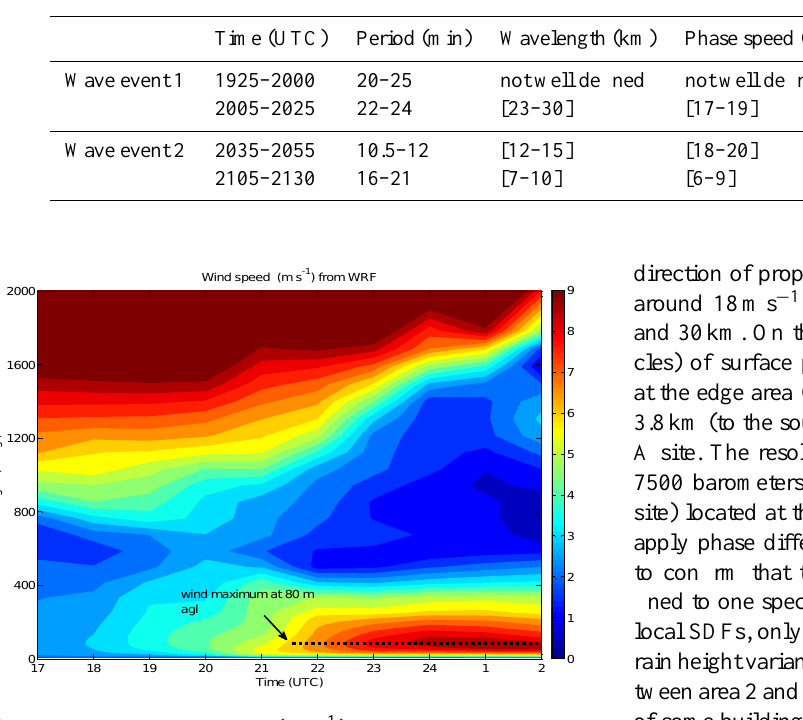
Figure 5. WRF wind speed (ms − 1 ) over Lannemezan from 17:00UTC of 2 July to 02:00UTC of 3 July from surface to 2000ma.g.l. The results indicate the appearance of the mountain- plain wind with maximum speed at around